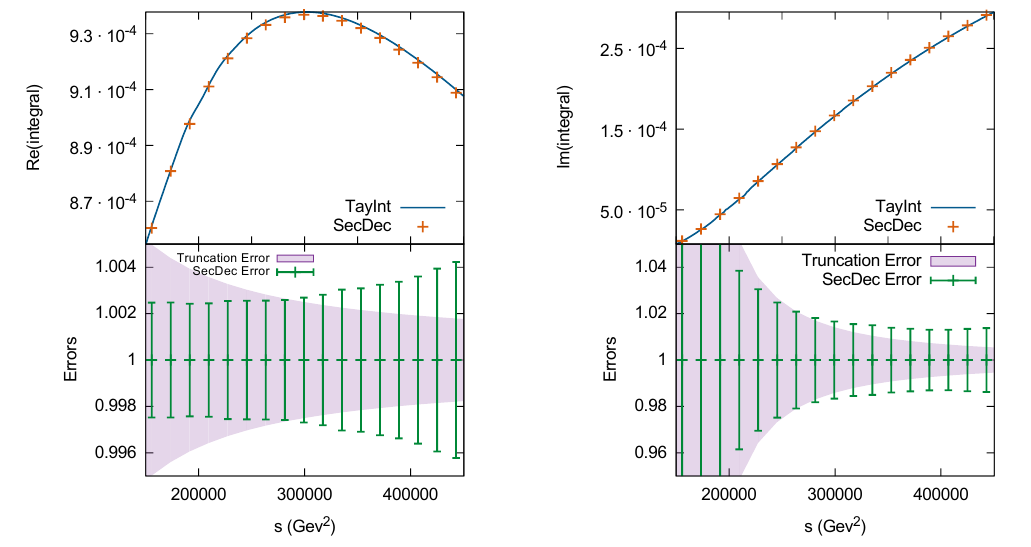
Figure 20 . The I39 Integral calculated at O ( (cid:15) 1 ) with a fourth-order series expansion. The scale s is over the 4 m 2 threshold, with u = (cid:0) 59858GeV 2 , m 2 = 1 p 1 plots show the relative TayInt and SecDec uncertainties, respectively.